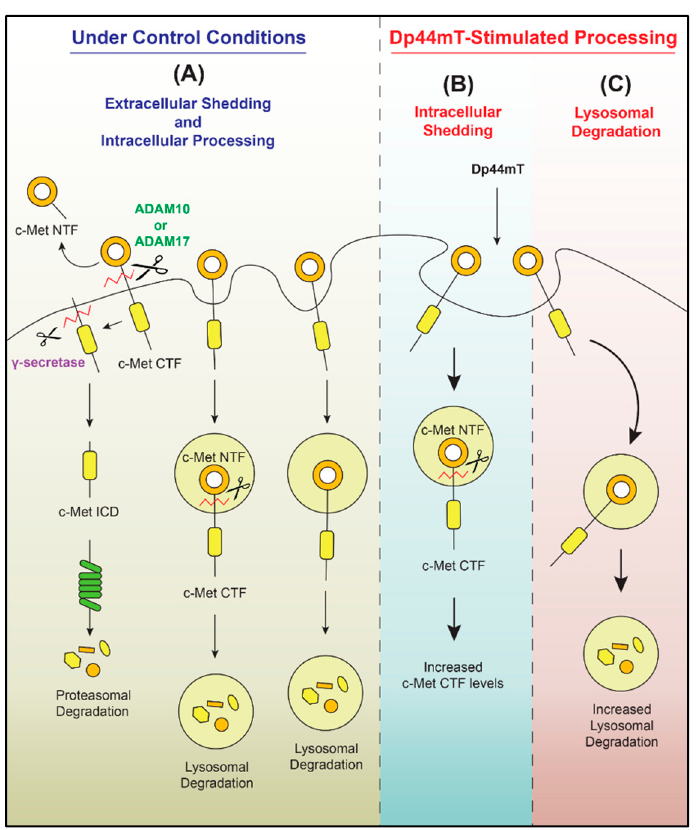
Figure 5. The thiosemicarbazone Dp44mT down-regulates c-MET expression in cancer cells. ( A ) Under control conditions, the c-MET protein undergoes proteolytic cleavage by membrane-bound proteases, such as ADAM-10 and / or -17. This process generates the c-MET N -terminal fragment (NTF) that is liberated from the cell and the c-MET C -terminal fragment (CTF). The c-MET CTF is then further cleaved by γ -secretase to produce a smaller fragment—the c-MET intracellular domain (ICD)—which is then readily degraded by the proteasome. The cleavage of c-MET could also occur intracellularly, and the c-MET protein is also internalized and degraded by lysosomal activity after the incubation of cells with Dp44mT. Dp44mT enhances ( B ) metalloproteinase-mediated intracellular shedding of the c-MET protein and ( C ) the lysosomal degradation of c-MET. Taken from [152].